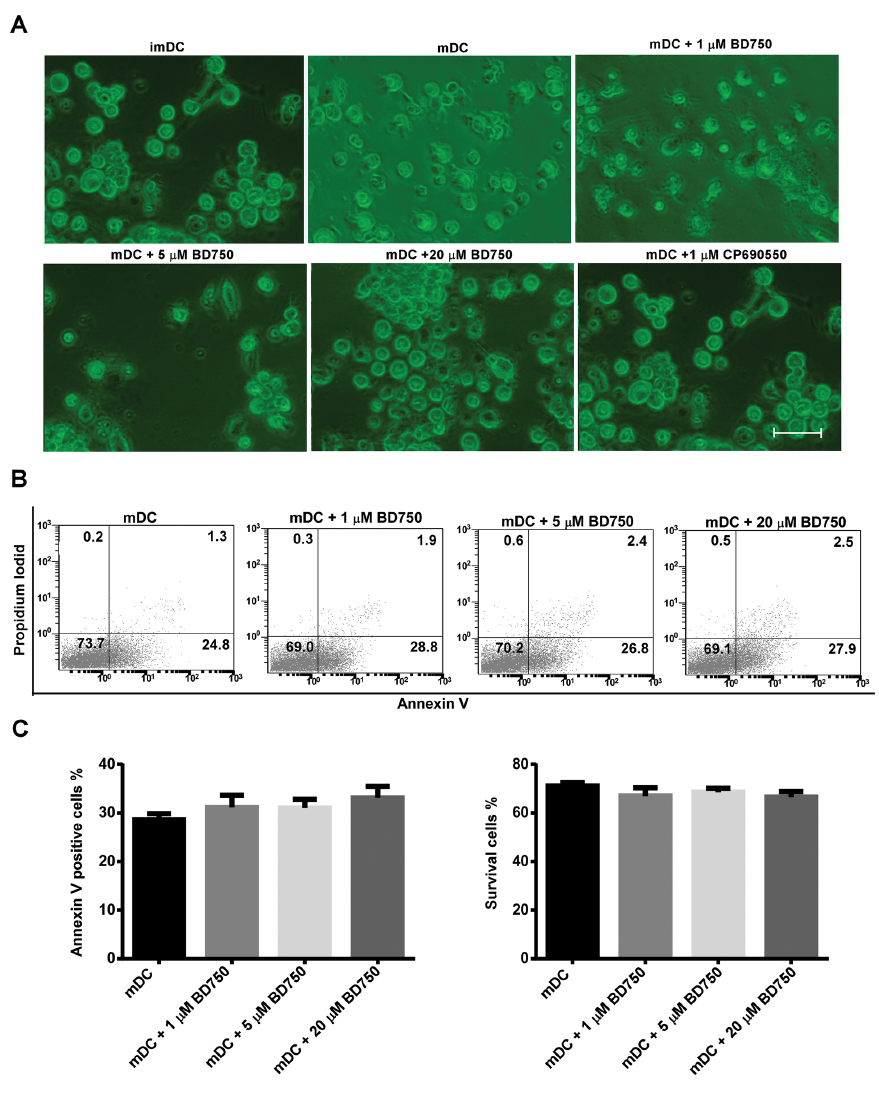
Figure 1. Morphological characteristics and survival of typical mDCs and BD750-treated DCs. BMDCs were stimulated with cytokines and treated with or without BD750 at the indicated dose or CP690550 for 12 h and then further stimulated with LPS for 24 h. The imDCs, mDCs and BD750-treated DCs were observed by a light microscope, and the percentages of apoptotic DCs in different groups of cells were determined by flow cytometry analysis. Data are representative images or expressed as the mean ± SEM of three independent experiments. (A) Light microscopic analysis of different groups of DCs. (B) Flow cytometry analysis of apoptotic cells. (C) Quantitative analysis of apoptotic cells. * P < 0.05, ** P < 0.01 versus the mDC